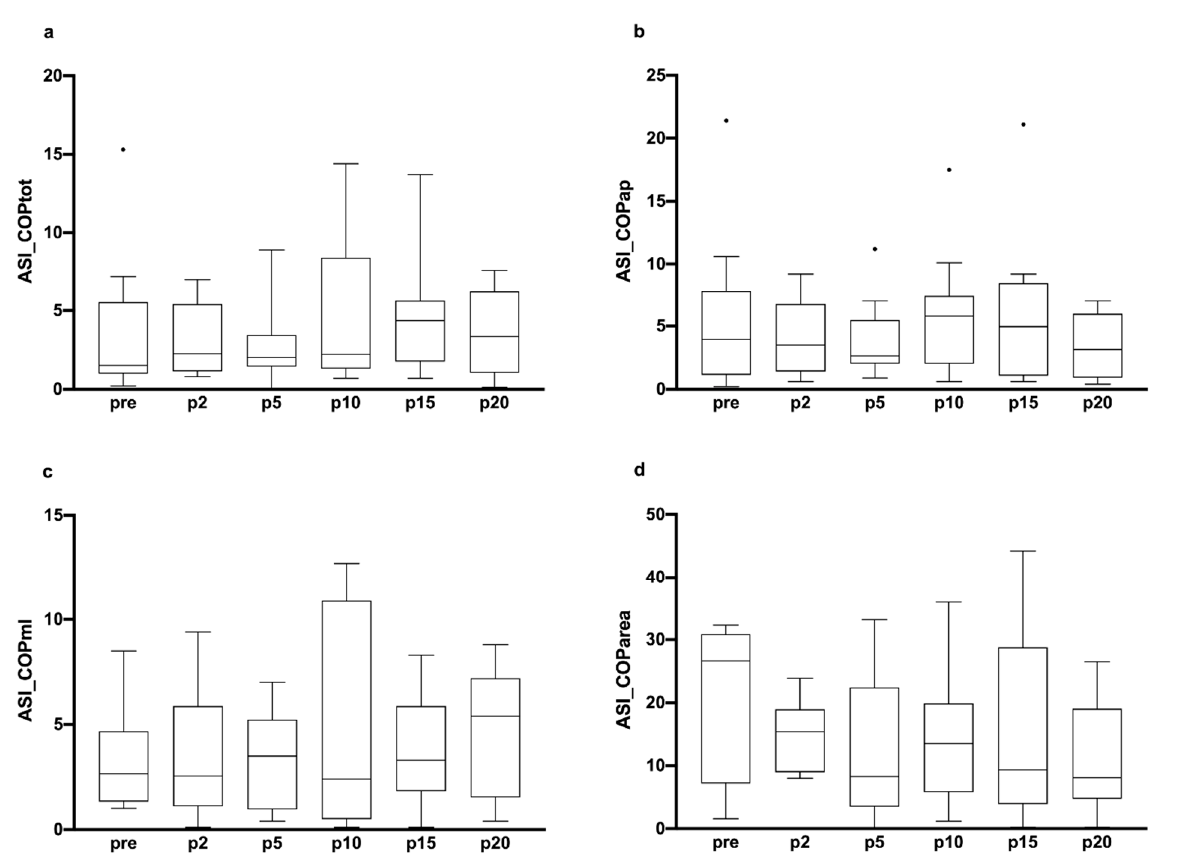
Figure 2. Boxplot representation of asymmetry indexes before (pre) and after (p2, p5, p10, p15 and p20) performing the warm-up routine. ASI: asymmetry indexes between both legs calculated for the following COP parameter: COPtot (total COP length; ( a )), COPap (COP length in the anteroposterior direction; ( b )), COPml (COP length in the mediolateral direction; ( c )) and COParea (COP ellipse area; ( d )). Assessments were performed before (pre), 2 min (p2), 5 min (p5), 10 min (p10), 15 min (p15) and 20 min (p20) after the completion of the warm-up. Small circles indicate data points beyond the whiskers. Table 2. COP variables from the D-leg in the SYM and ASYM